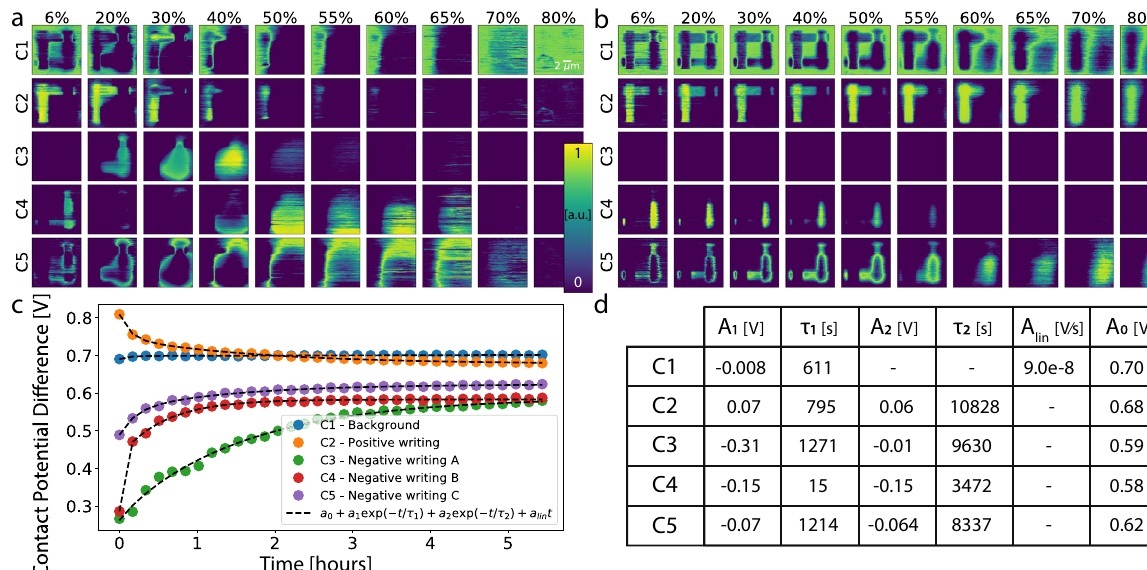
Fig. 3 Dictionary Learning analysis of the KPFM data. The spectral decomposition of the complete dataset of contact potential difference signal evolution measured in the two samples and at ten humidities yields fi ve components. The weight maps for the ( a ) down-polarised and ( b ) up-polarised sample demonstrate spatially localised features, which once correlated with the ( c ) time-dependent components yield a clear separation between the background response ( C 1), and the areas of positive ( C 2) and negative ( C 3 – 5) charge. The negative charge region is split into co-located concentric structures, reminiscent of Matryoshka dolls. Components C 2 – C 5 can be fi tted with double exponential decays, each yielding ( d ) two very different time